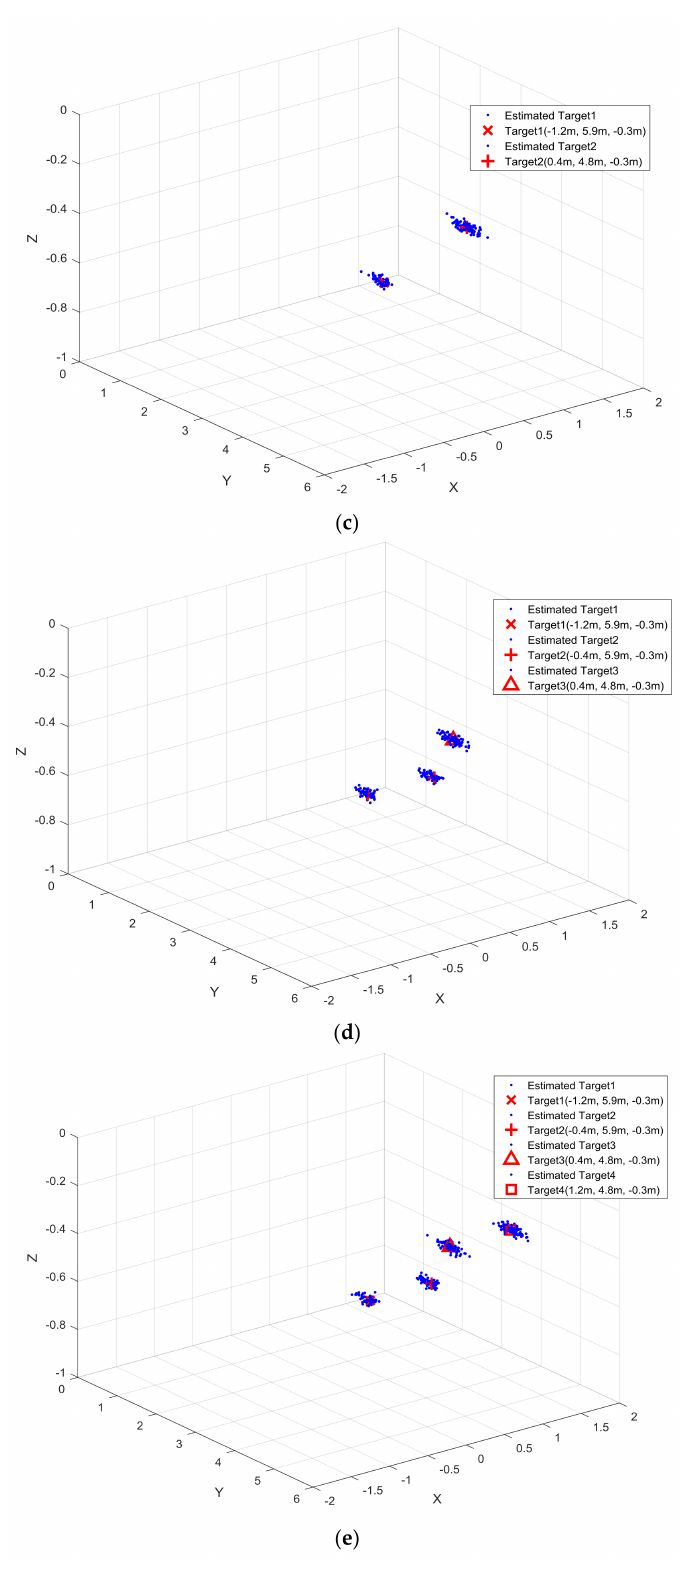
Figure 8. Detection results. ( a ) 1st experiment with one target; ( b ) 2nd experiment with two targets; ( c ) 3rd experiment with two targets; ( d ) 4th experiment with three targets; ( e ) 5th experiment with four